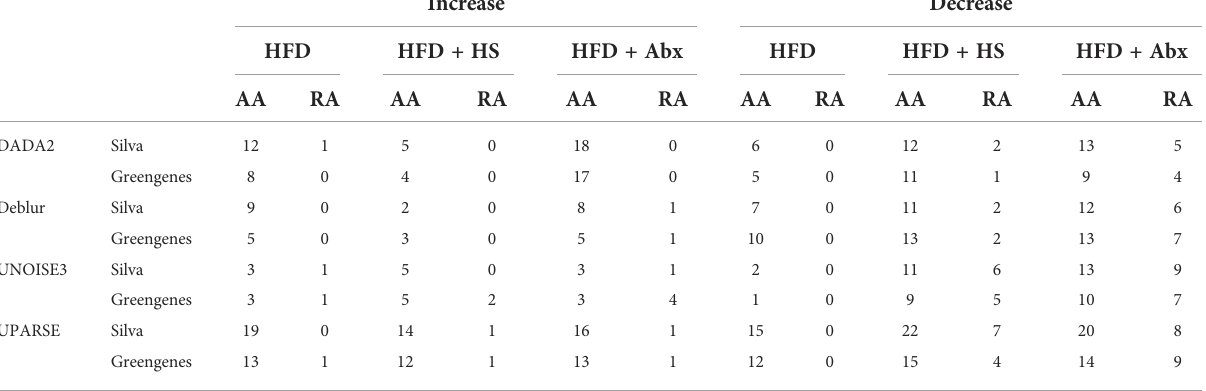
TABLE 2 Numbers of signi fi cantly different taxa between treated group and ND